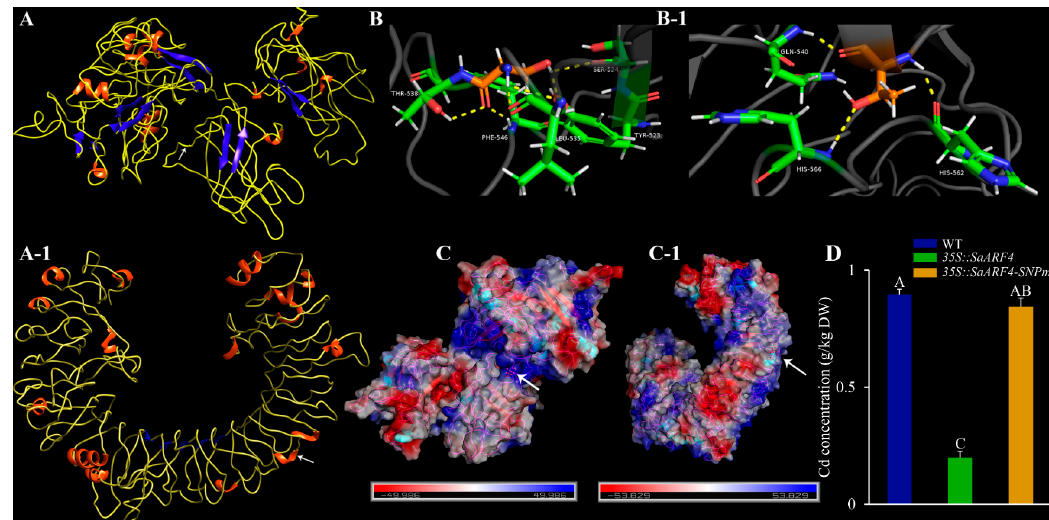
Figure 7. Variations in protein structures of SaARF4 -SNPm and Cd content of transgenic plants. The protein structures of SaARF4 and SaARF4 -SNPm were displayed in ( A ) and ( A-1 ), respectively. ( B ) ( SaARF4 ) and ( B-1 ) ( SaARF4 -SNPm) indicated the mutant aa (the orange one) and its surrounding interaction aa (the green ones). The charge distribution of SaARF4 and SaARF4 -SNPm was showed in ( C ) and ( C-1 ), respectively. The red color indicated the negative charge; the blue color indicated the positive charge; the white color indicated the neutral charge; the white arrows indicated the positions of the mutant sites. ( D ) The Cd accumulation of NHE WT plants (the blue color), 35S::SaARF4 (the green color) and 35S::SaARF4-SNPm (the orange color). DW, dry weight. Different capitals indicated different significance, p < 0.01.